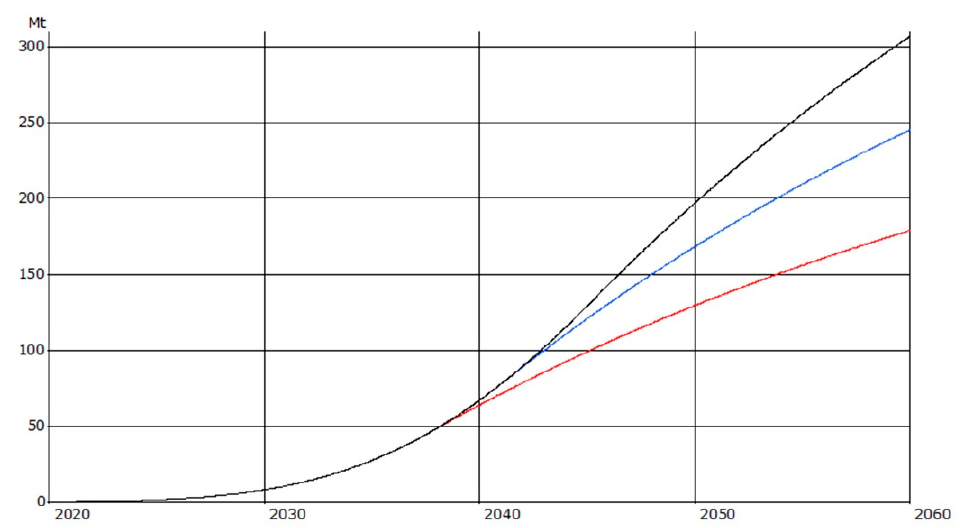
Figure 3. Evolution of the ‘ demand of aggregates for concrete’ (green) in the German construction